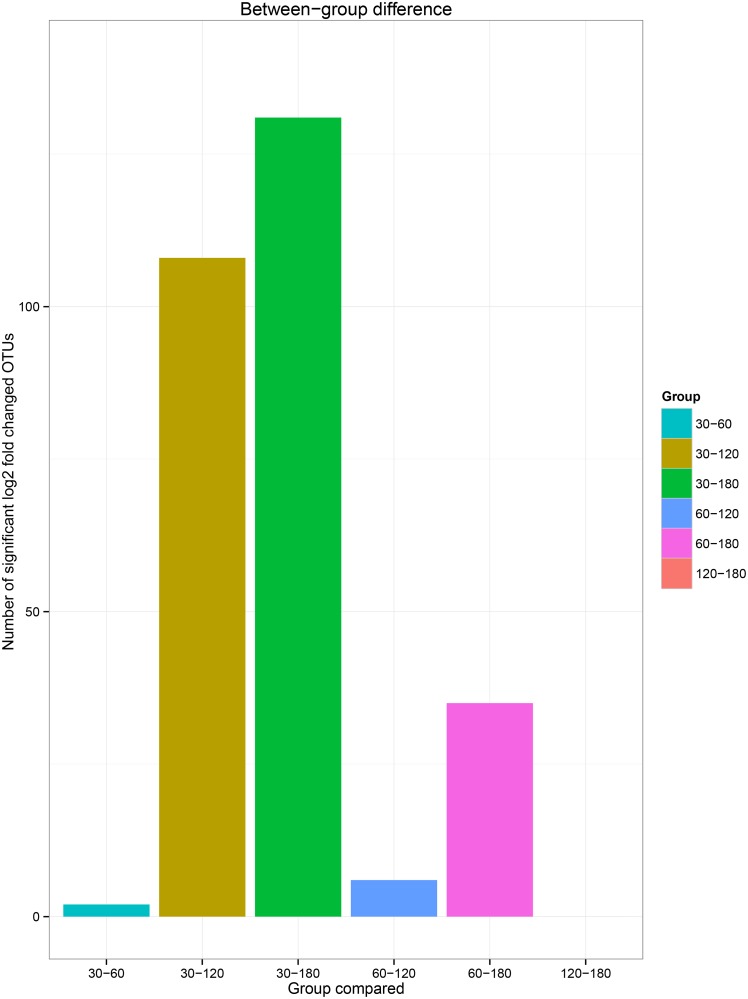
Analysis of the within-group similarity of two different age groups.The higher number of significantly changed expressed deduced ACS amino acid sequences between two age groups with a lower similarity between them.